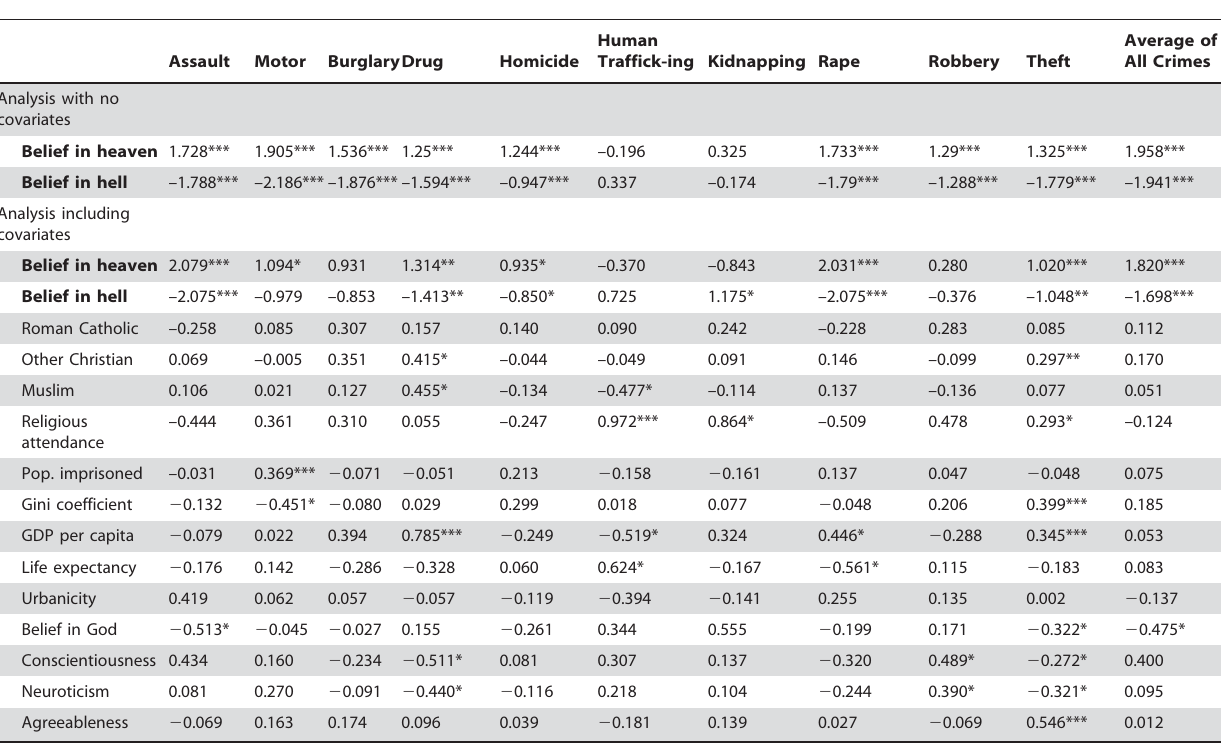
Table 1. Regression of individual crime rates on beliefs in heaven, hell, and 13